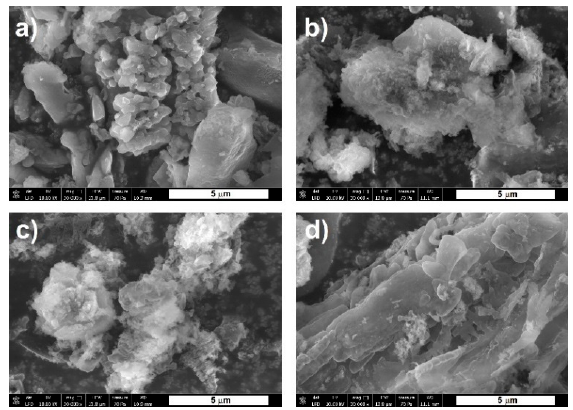
Figure 6. SEM images of carbon nitrides synthesized from various precursors and under different condensation conditions, ( a ) D-10/550/4, ( b ) D-10/600/4, ( c ) T-10/600/4, ( d ) M-10/600/4.